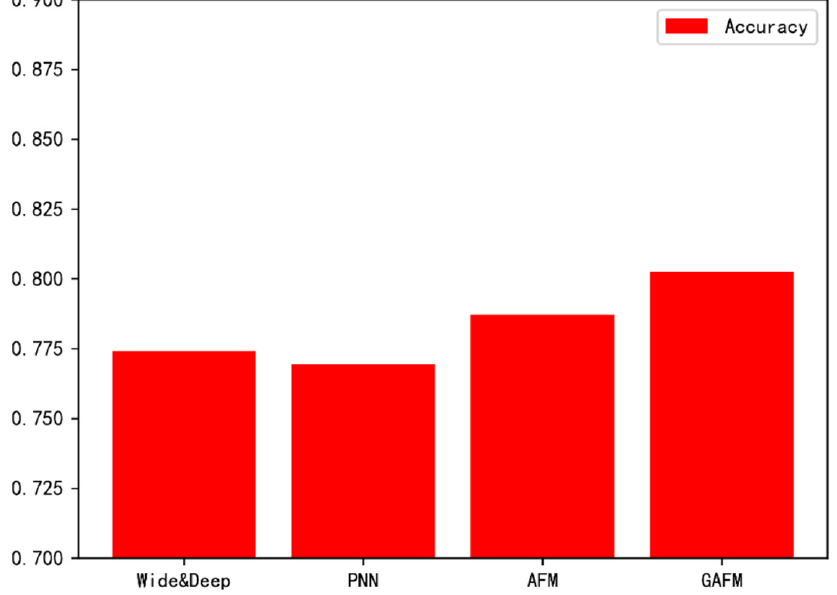
Figure 16. The accuracy of each model is compared. As can be seen from Figure 17, the running time of GAFM model on dataset 1 is significantly less than that of Wide & Deep model and AFM model, which is similar to that of PNN model.